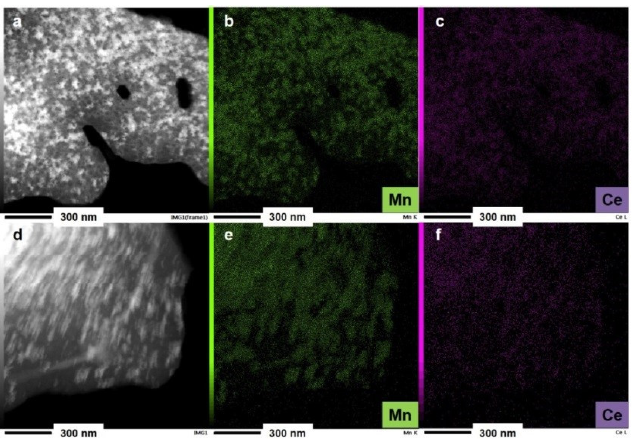
Figure 4. TEM images (dark field mode) and related EDX Mn, Ce elemental mappings of MnCe (1:0.5) before ( a – c ) and after ( d – f ) reaction.